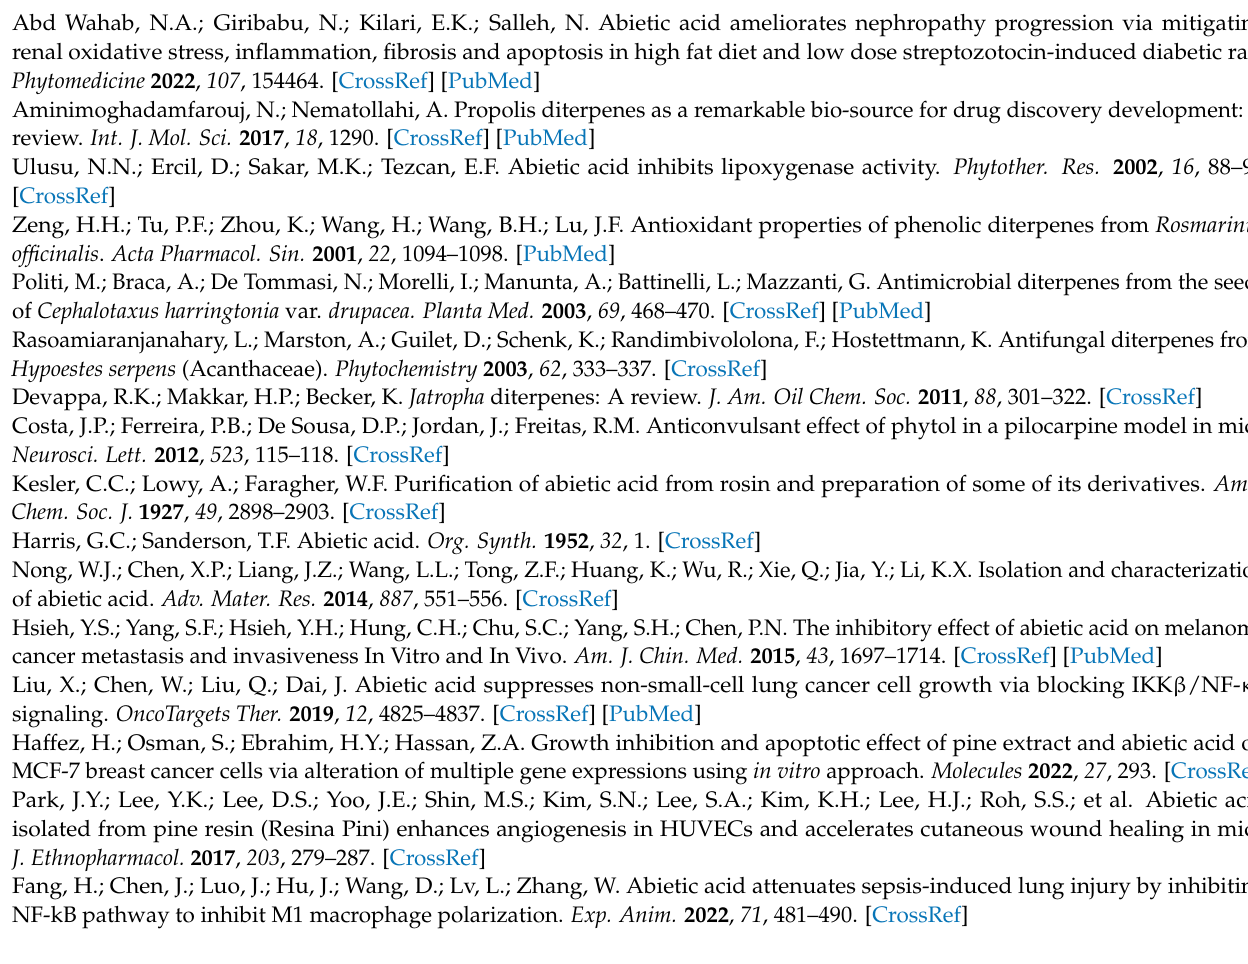
Figure S1: Cell viability assay to determine the optimal AA concentration, Figure S2: Cell viability assay to determine the optimal LPS concentration, Figure S3: The NO concentration was used to determine the optimal concentration of